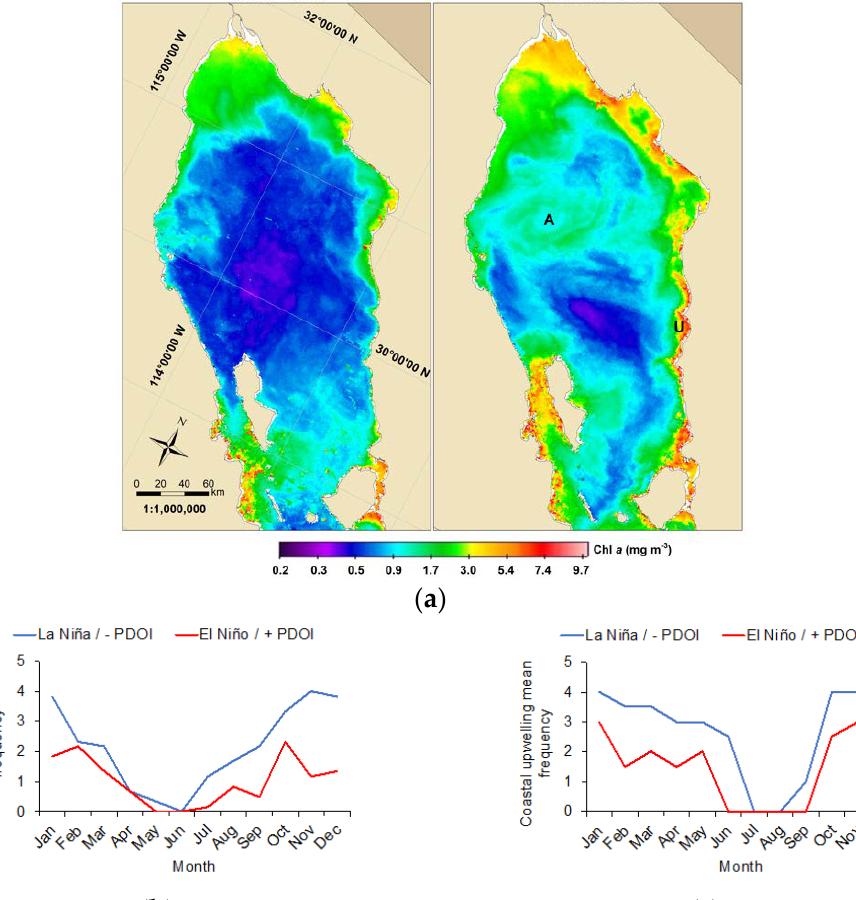
Figure 8. ( a ) Chlorophyll a satellite images exhibiting El Niño/+PDOI and La Niña/−PDOI condi- tions in the Northern Gulf of California; ( b ) Mean annual frequency of anticyclonic eddies during positive and negative ENSO/PDO; ( c ) Mean annual frequency of coastal upwelling during positive and negative ENSO/PDO. Figure 9a,d show Chl a and SST satellite images, respectively, of the CGC under positive/negative ENSO and PDO conditions. Coastal upwelling activity is reduced by ~38% during El Niño and positive PDO with respect to La Niña and negative PDO conditions (Figure 9b). Mean annual frequency of filaments is reduced by ~55% during El Niño and positive PDO with respect to La Niña and negative PDO conditions (Figure 9c). The mean annual duration of the water mass intrusion increases ~5% during positive ENSO and PDO with respect to negative conditions (Figure